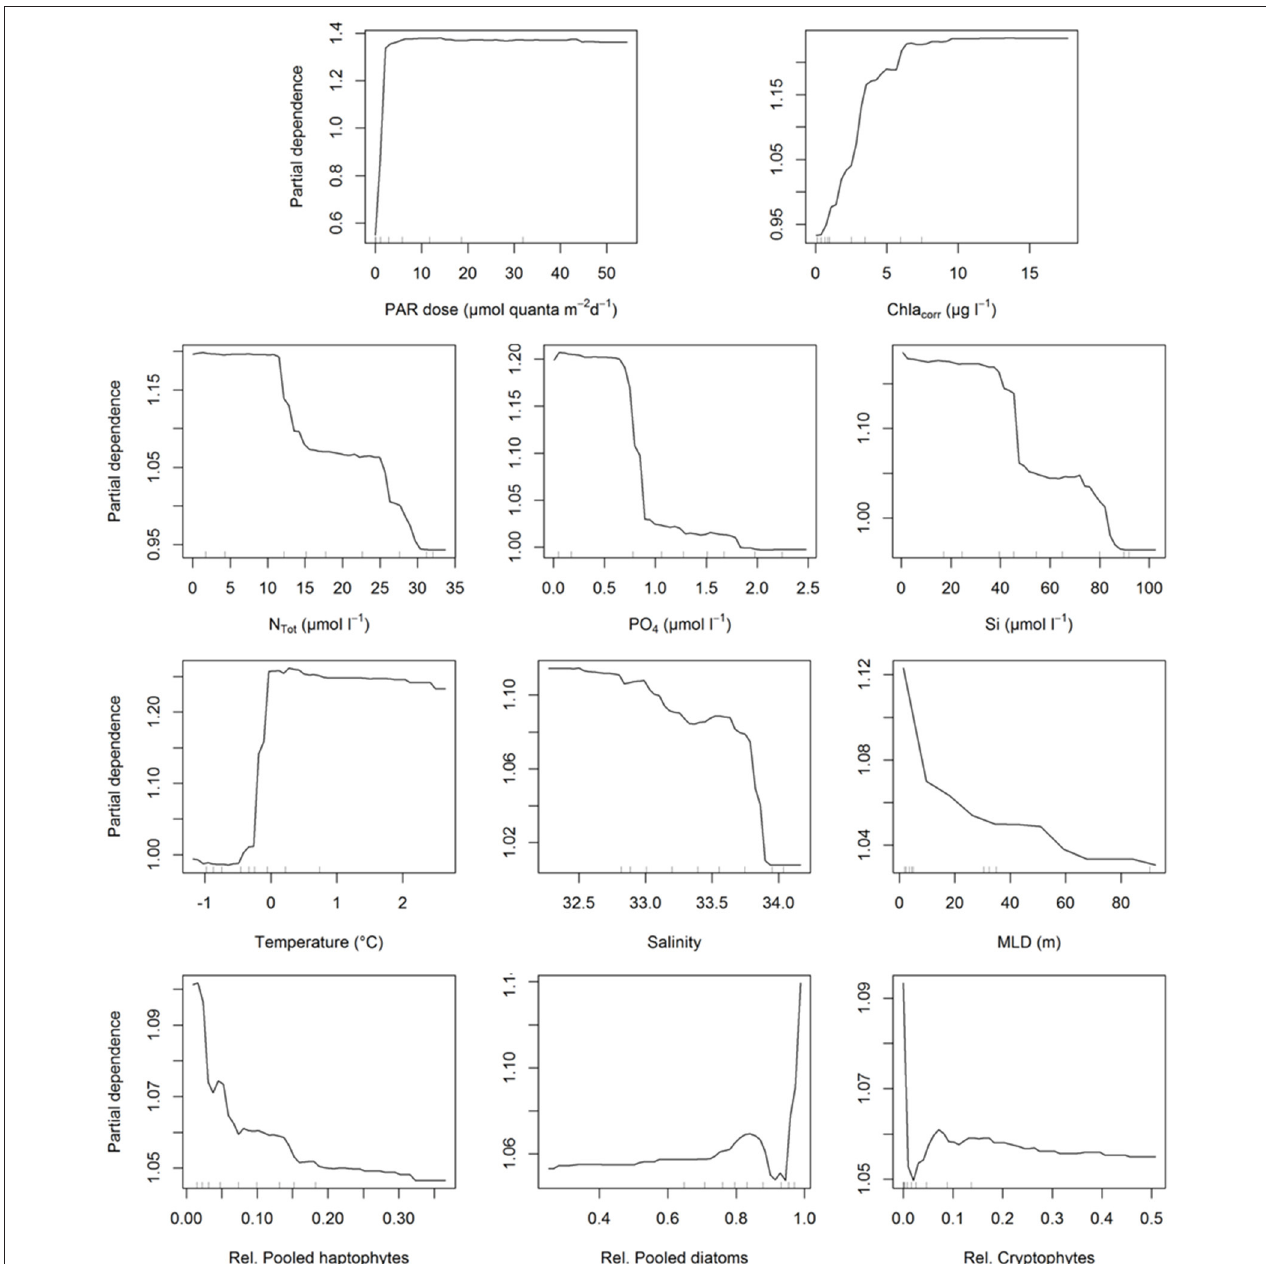
FIGURE 9 | Partial dependence plots for all the variables included in the maximum random forest model to assess the importance of each value in the modeling op PP. The partial dependence plots for the minimal model are shown in Supplementary Figure 3. Inner tick marks represent the 10%